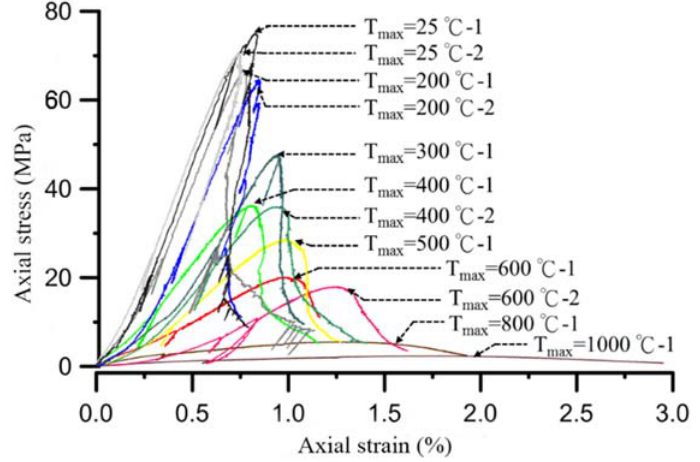
Figure 5. Completed uniaxial compressive curves for concrete subjected to various temperatures.